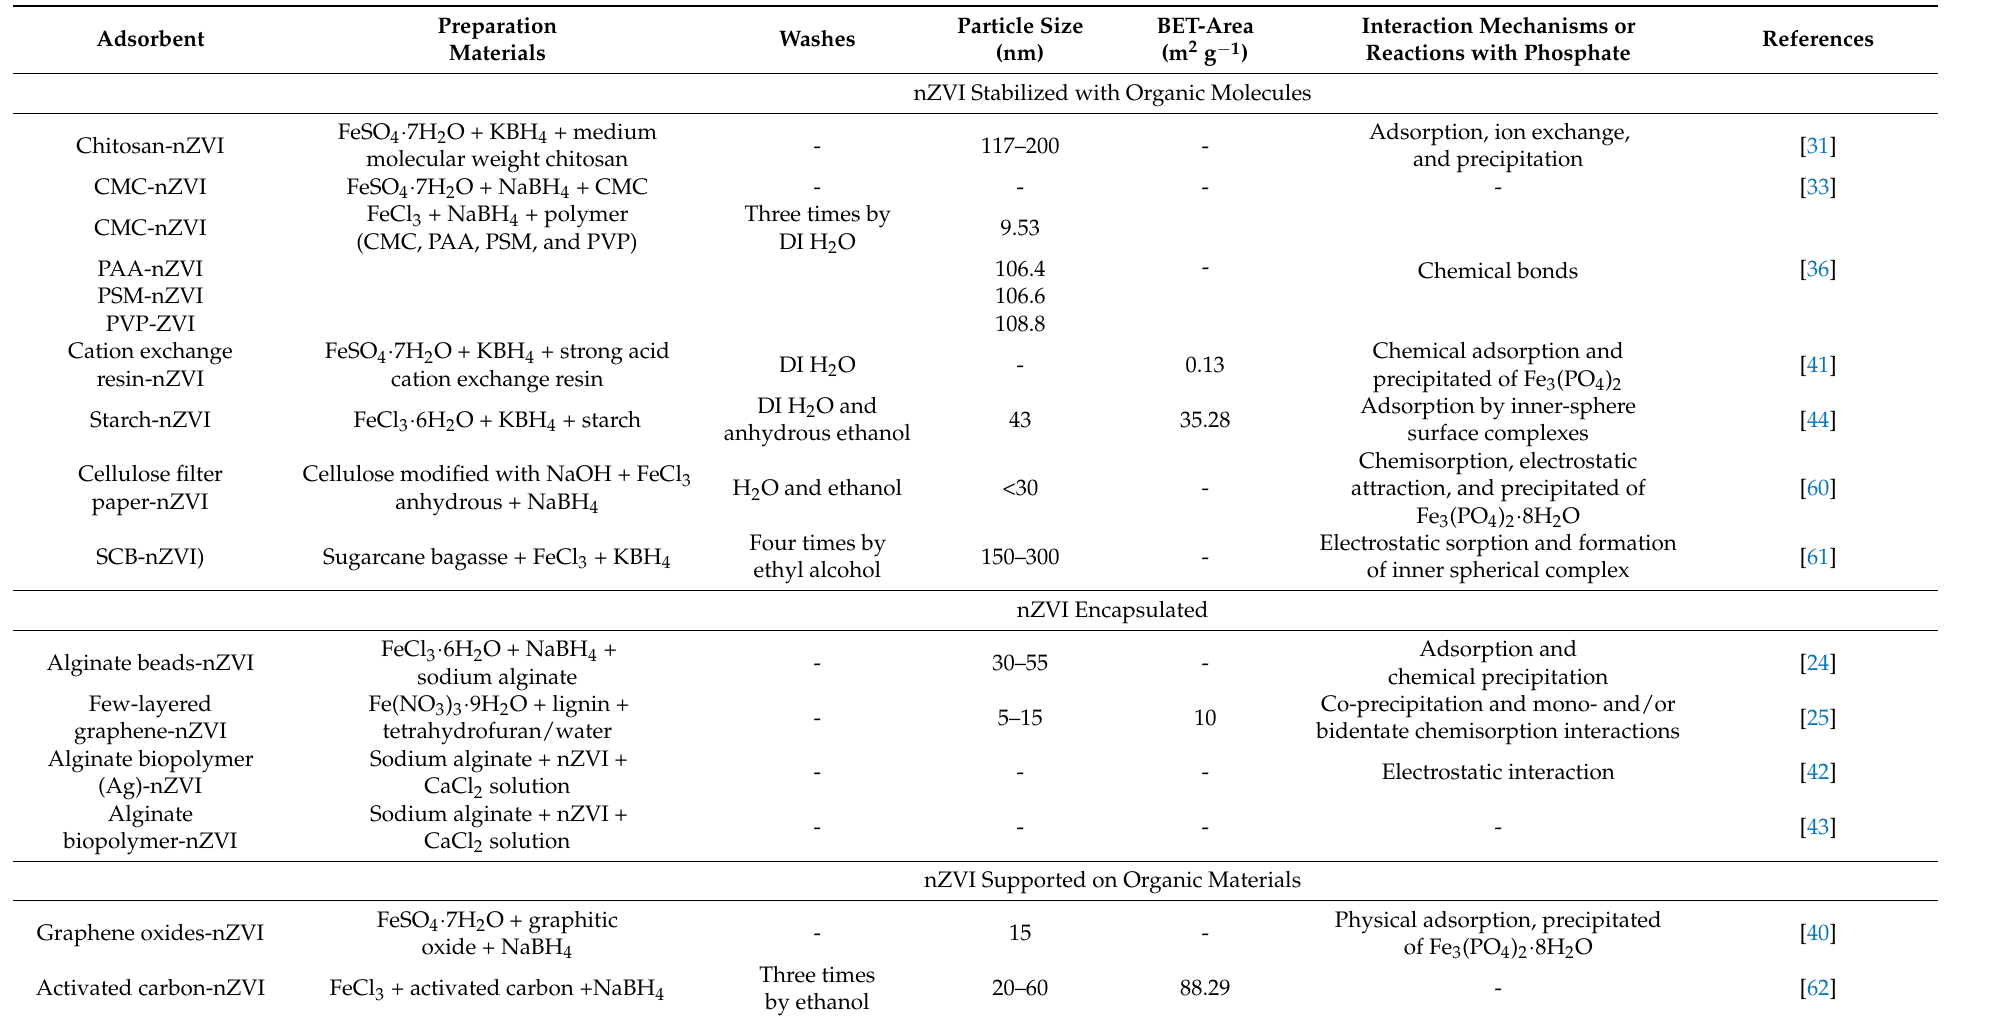
Table 2. Properties of nanocomposites of nZVI and mechanisms for phosphate